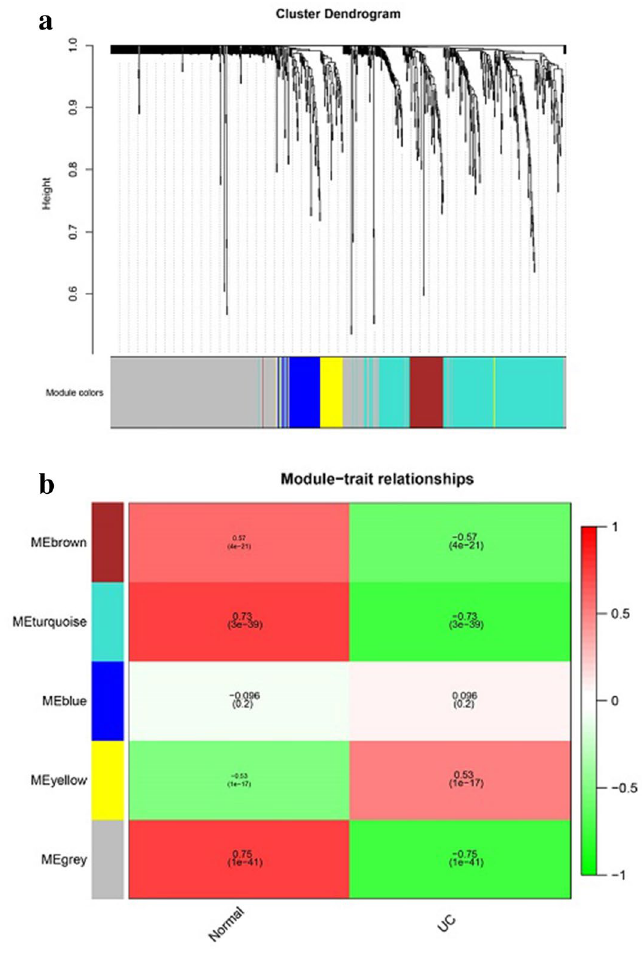
Figure 2. ( a ) shows the cluster dendrogram of UC-related modules, including five modules. ( b ) shows the heatmap of module-trait relationships made by WGCNA R package (https ://cran.rstud io.com/web/packa ges/ WGCNA